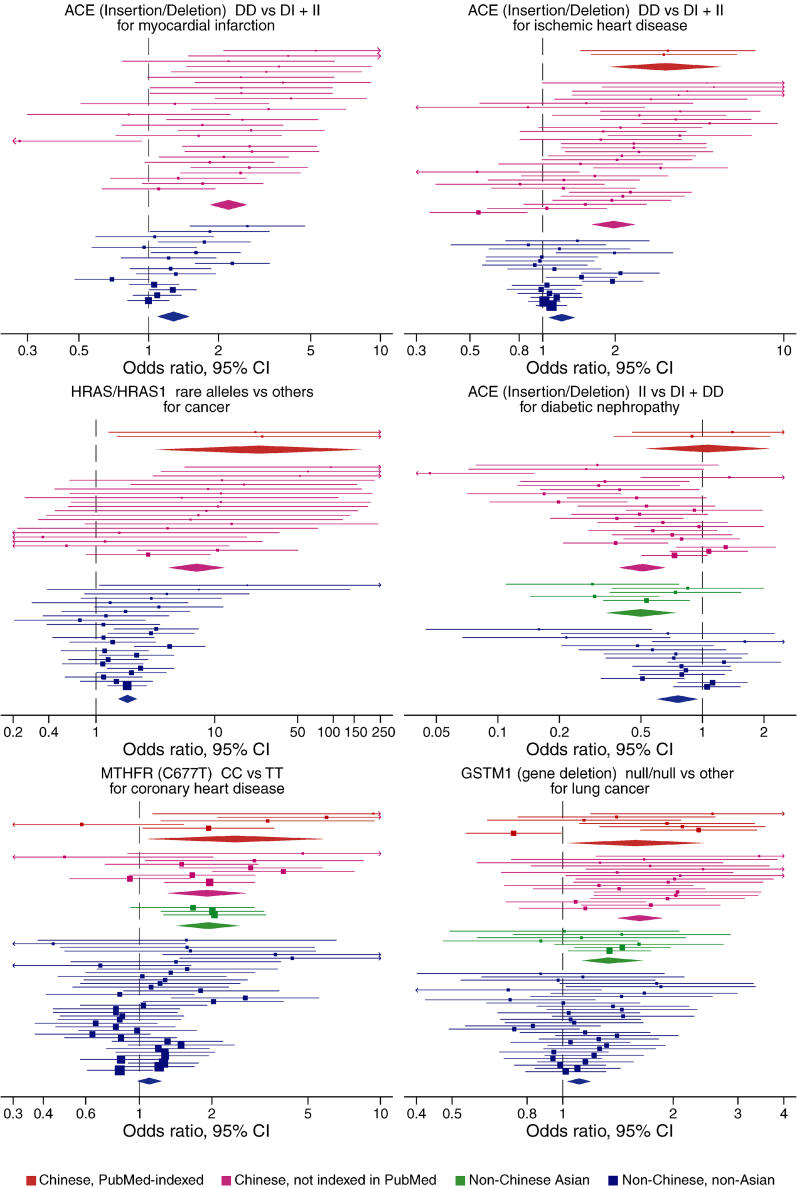
Meta-Analyses of Gene-Disease Associations in a Large Number of Both Non-Chinese and Chinese StudiesEach study is shown by its odds ratio and 95% confidence intervals (CIs). The box of the point estimate is proportional to the study weight. Also shown are summary estimates by random effects calculations (diamonds). Summary estimates are obtained separately for Chinese studies indexed in PubMed (red), Chinese studies not indexed in PubMed (pink), non-Chinese studies of Asian descent populations (green), and studies of persons of non-Asian descent (blue). An odds ratio of 1 means no genetic effect, odds ratios larger than 1 mean genetic predisposition, and odds ratios less than 1 mean genetic protection.